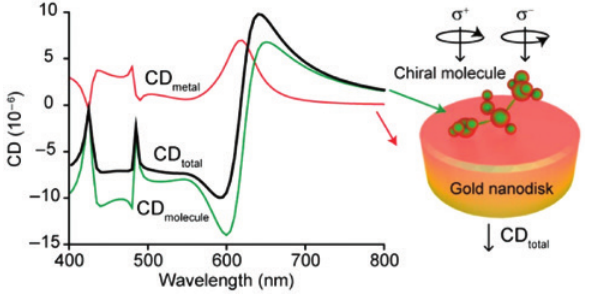
Figure 5: Contributing factors to the CD signals of the gold nanodisk/chiral molecule hybrid system (black line: total CD, red line: CD contribution of the gold nanodisk array, green line: CD contribution of the adsorbed chiral molecules). Figure 6: Lateral forces on chiral molecules in an evanescent